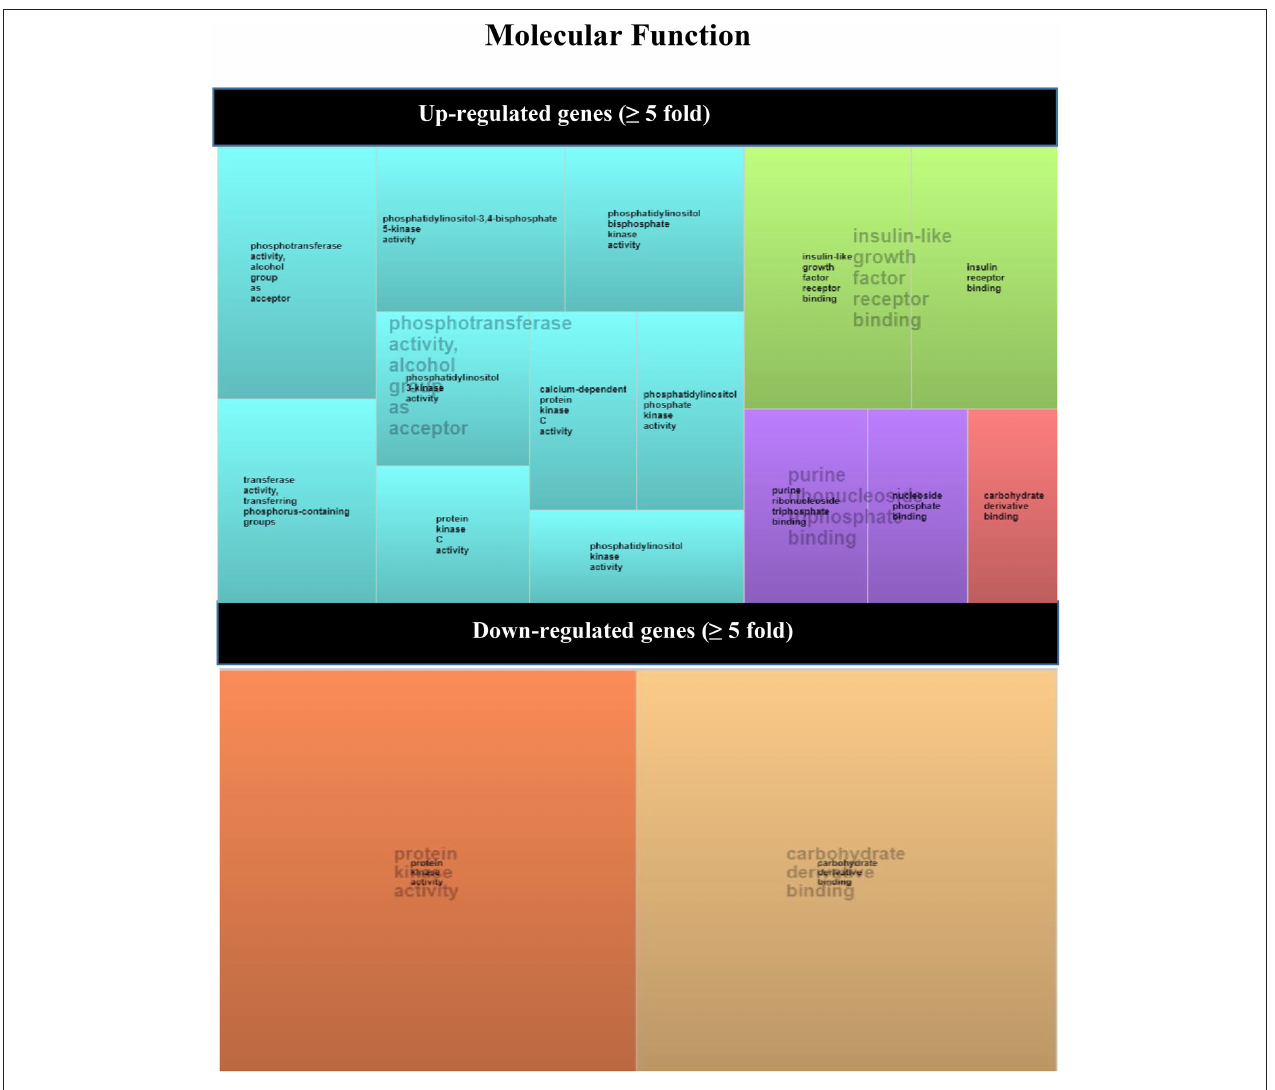
FIGURE 4 | REVIGO TreeMap view of GO terms enriched between up- (upper TreeMaps) or down-regulated (lower TreeMaps) genes in biopsies from + DSA/ + AMR patients vs. control recipients (–DSA/–AMR, + DSA/–AMR, and –DSA). Each rectangle is a single cluster representative. The representatives are joined into “superclusters” of loosely related terms that are visualized with distinct colors (indicated by centralized black text). The size of the rectangles reflects the enrichment of the GO